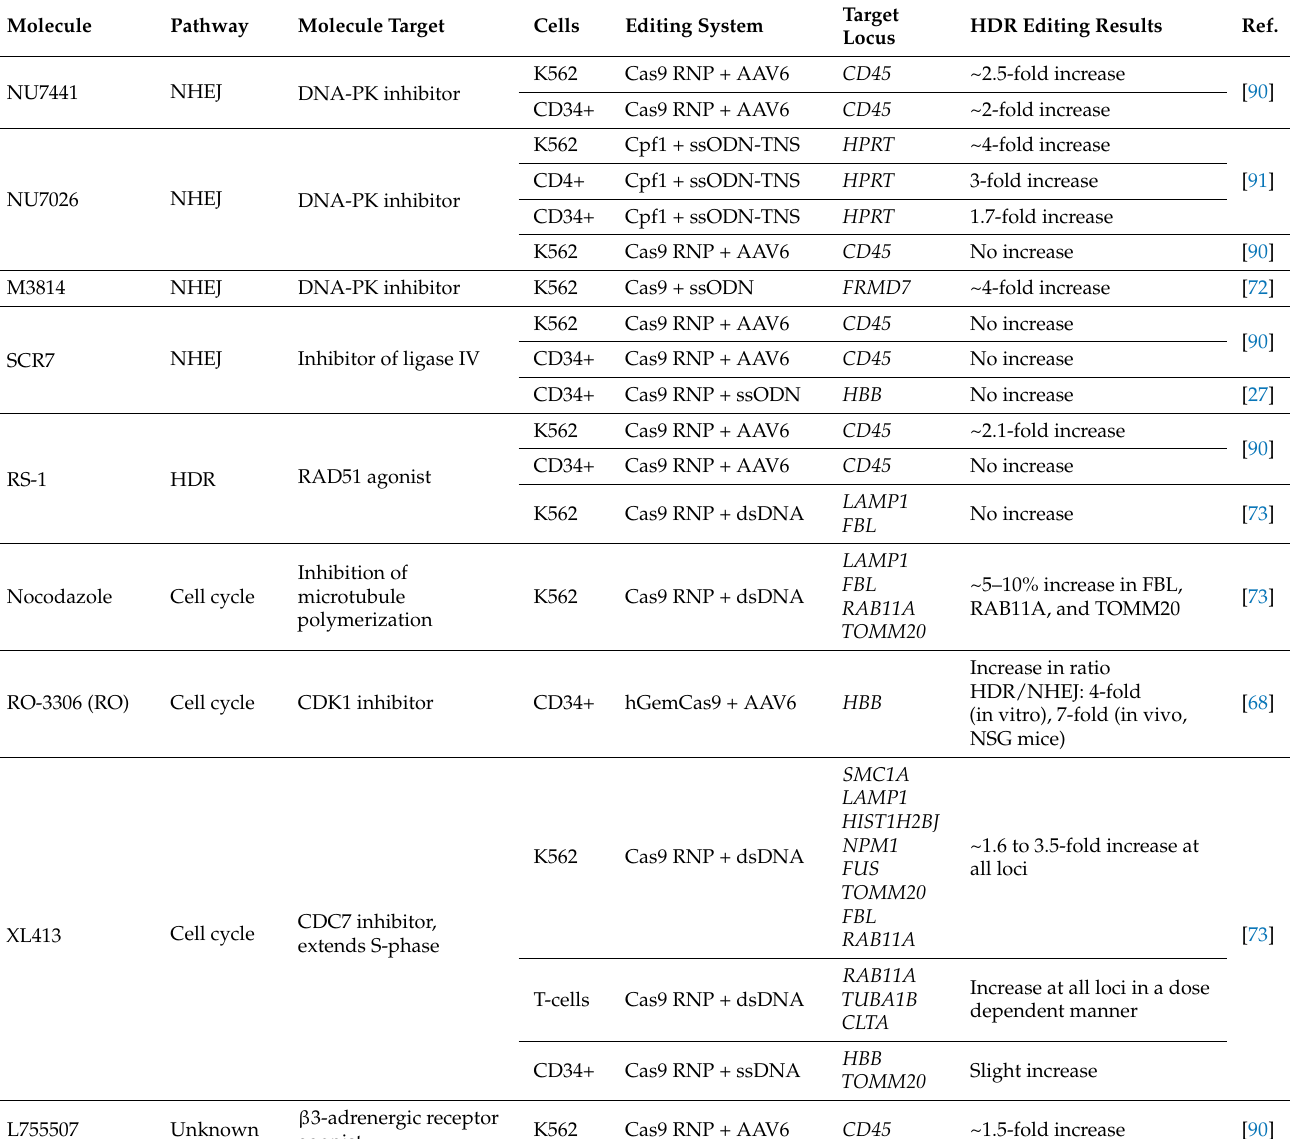
Table 2. Small molecules tested in hematopoietic cells to improve HDR-mediated genome editing. Molecule Pathway Molecule Target Cells Editing System